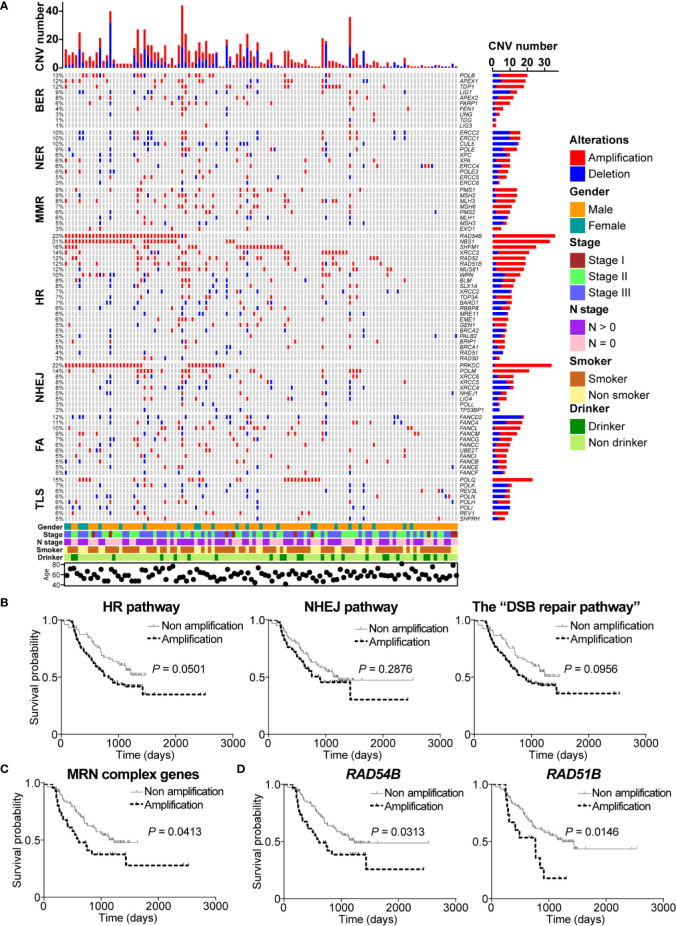
DNA damage repair (DDR) pathway genes had significant copy number variations (CNVs) in esophageal squamous cell cancer (ESCC). (A) A complex heatmap that shows the gene CNV profile in DDR pathways (samples with no CNVs are removed). The top panel presents the number of gene CNVs in each of ESCC samples, and the right panel shows the number of gene CNVs in each gene. (B) Amplification of homologous recombination (HR), non-homologous end joining (NHEJ), and the “DSB repair pathway” was associated with poorer overall survival. The amplification of MRE11-RAD50-NBS1 (MRN) complex genes (C), RAD54B, and RAD51B
(D) was related to shorter overall survival.